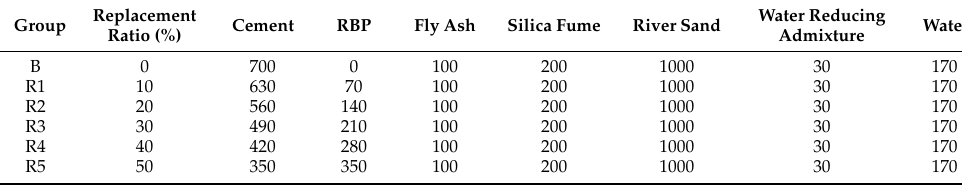
Table 6. UHPC mixture ratio of RBP (kg/m 3